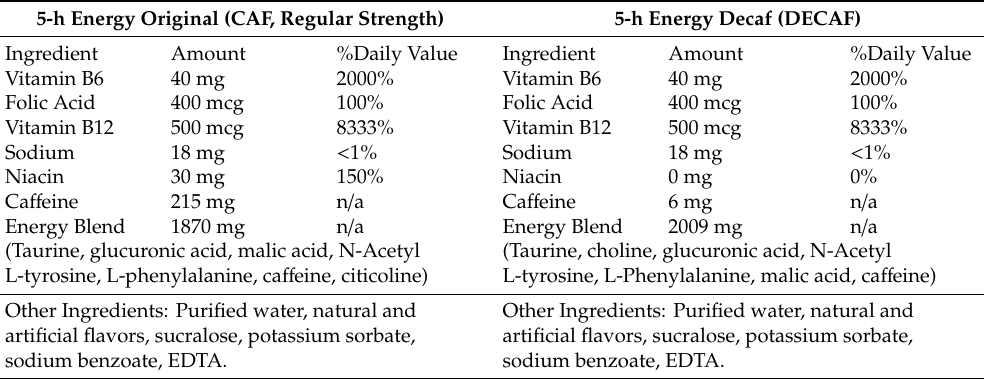
Table 1. Ingredient profiles of the ca ff eine-containing CAF (5-h Energy original) and DECAF (5-h Energy Deca ff einated)